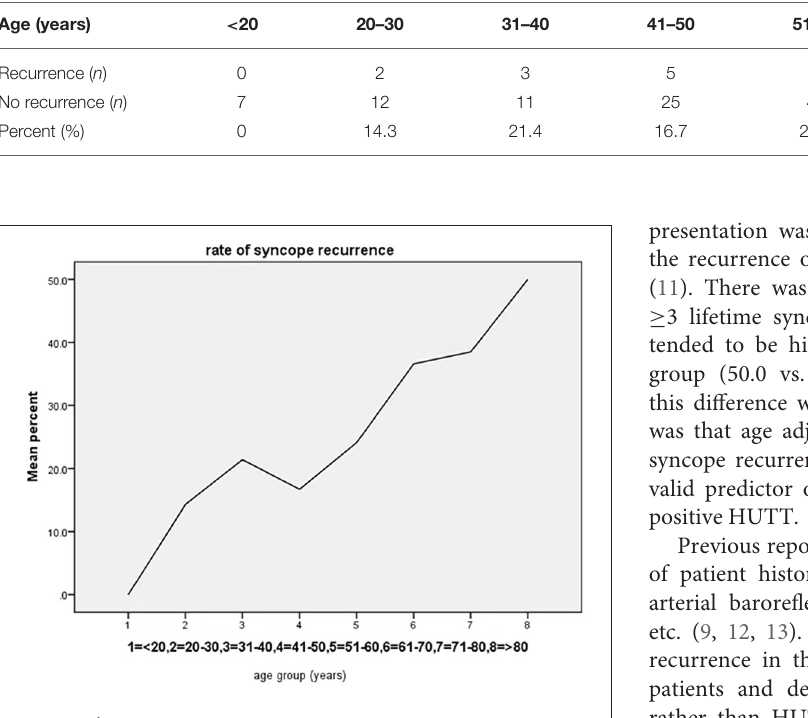
FIGURE 3 | Age-trend for syncope recurrence based on the percentage within each age group. The rate of syncope recurrence increased with advancing